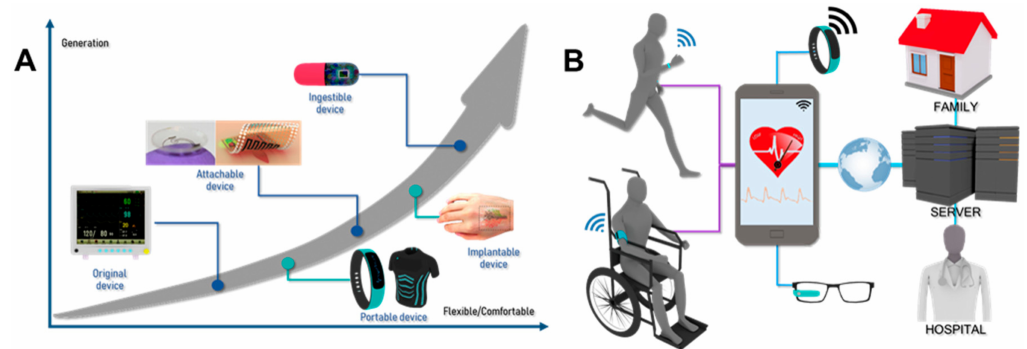
Figure 1. Industrial wearable technologies. ( A ) Evolution of wearable medical devices ( B ) Application of wearable devices in the healthcare and biomedical monitoring systems. Reproduced with permission from Hwang, I.; et al. Multifunctional smart skin adhesive patches for advanced health care; Wiley, 2018 [9] and Yao, H.; et al. A contact lens with embedded sensor for monitoring tear glucose level; Elsevier, 2011